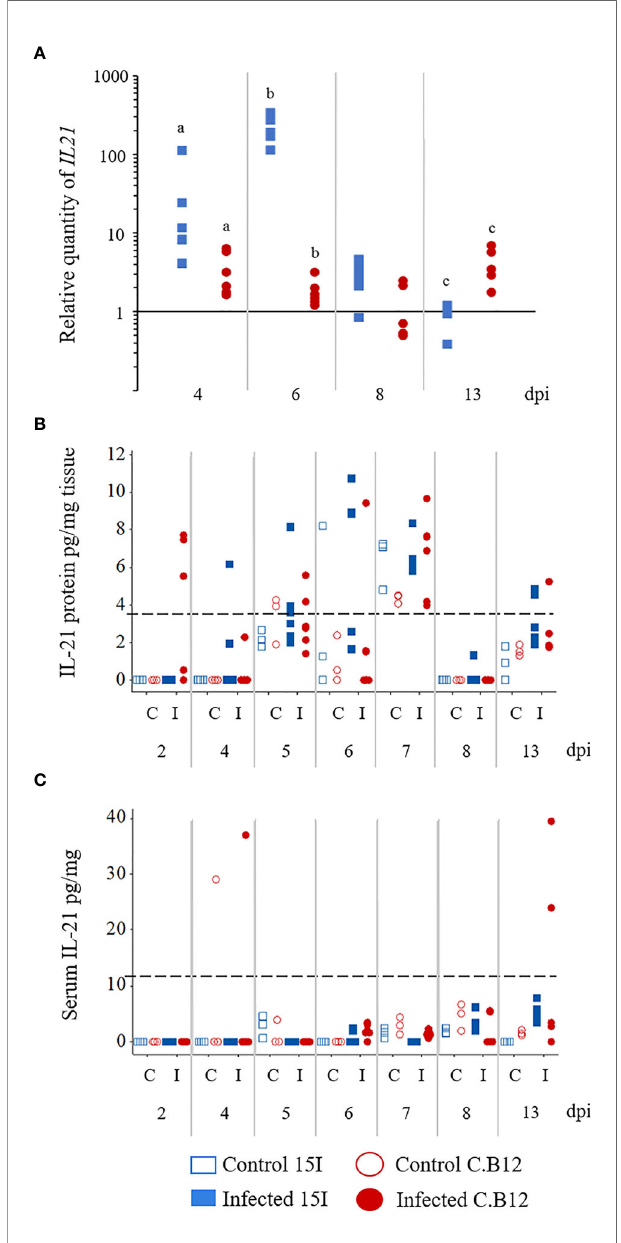
FIGURE 6 | Kinetics of IL21 mRNA transcription (A) and protein expression (B) in the jejunum and IL-21 protein levels in the serum (C) of E. maxima -infected chickens. Three-week old birds were orally inoculated with 100 oocysts of E. maxima or sterile water (control birds) and jejunum and serum samples collected at various days post-infection as indicated. Data are presented as individual birds. For RT-qPCR data, the relative quantity (RQ) of mRNA transcription of individual infected birds was calculated relative to the mean of control birds of the same line at individual time points and normalized using the 28S reference gene. Matching letters denote signi fi cant differences between groups on the same day ( p < 0.05, n = 3 for control and n ≥ 5 for infected groups). C, control; I,